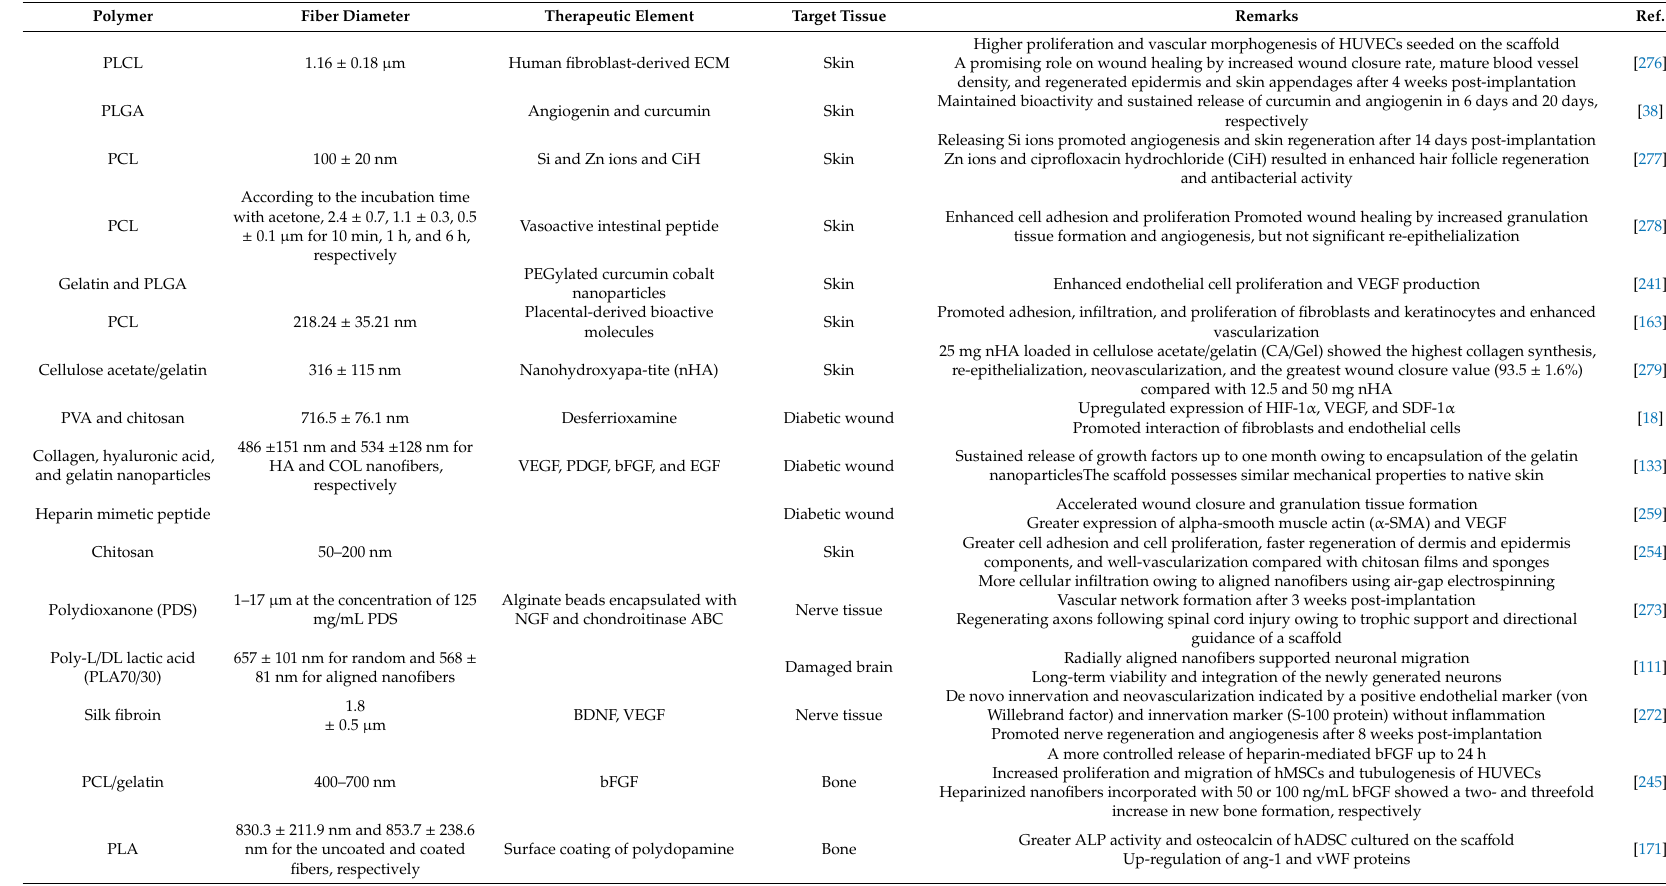
Table 6. A summary of experimental studies performed for improving tissue regeneration via applying angiogenic electrospun nanofibrous sca ff olds. BDNF, brain-derived neurotrophic